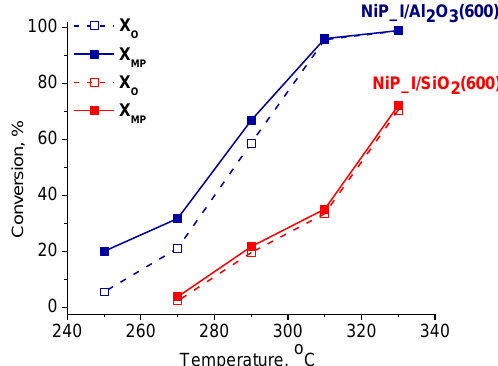
Figure 11. Temperature effect on the conversion of methyl palmitate (solid symbols, solid lines) and oxygen-containing compounds (empty symbol, dash lines) over NiP_I/Al 2 O 3 and NiP_I/SiO 2 catalysts (P H2 = 3.0 MPa, T = 250–330°C, H 2 /feed = 600 Nm 3 /m 3 , methyl palmitate LHSV = 3.6–9 h −1 ).